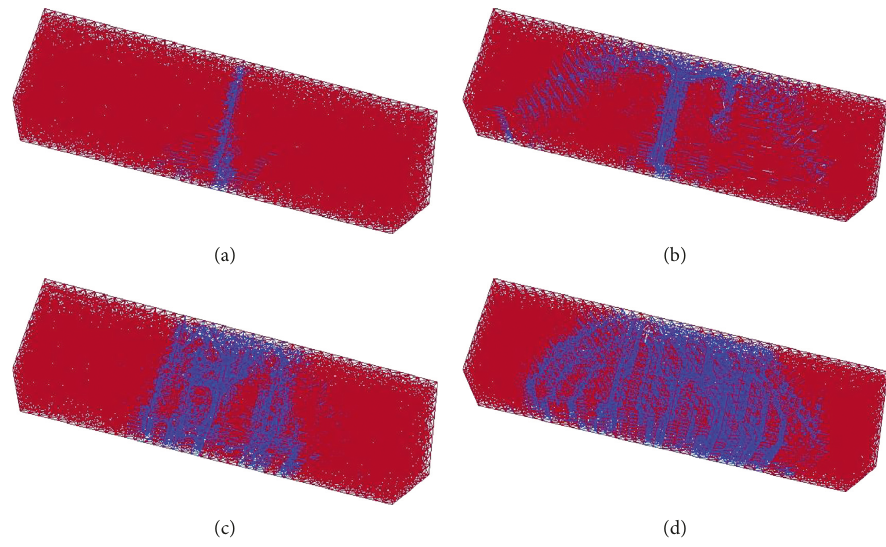
Figure 14: Crack patterns in UHPFRC with different fiber contents: (a) V